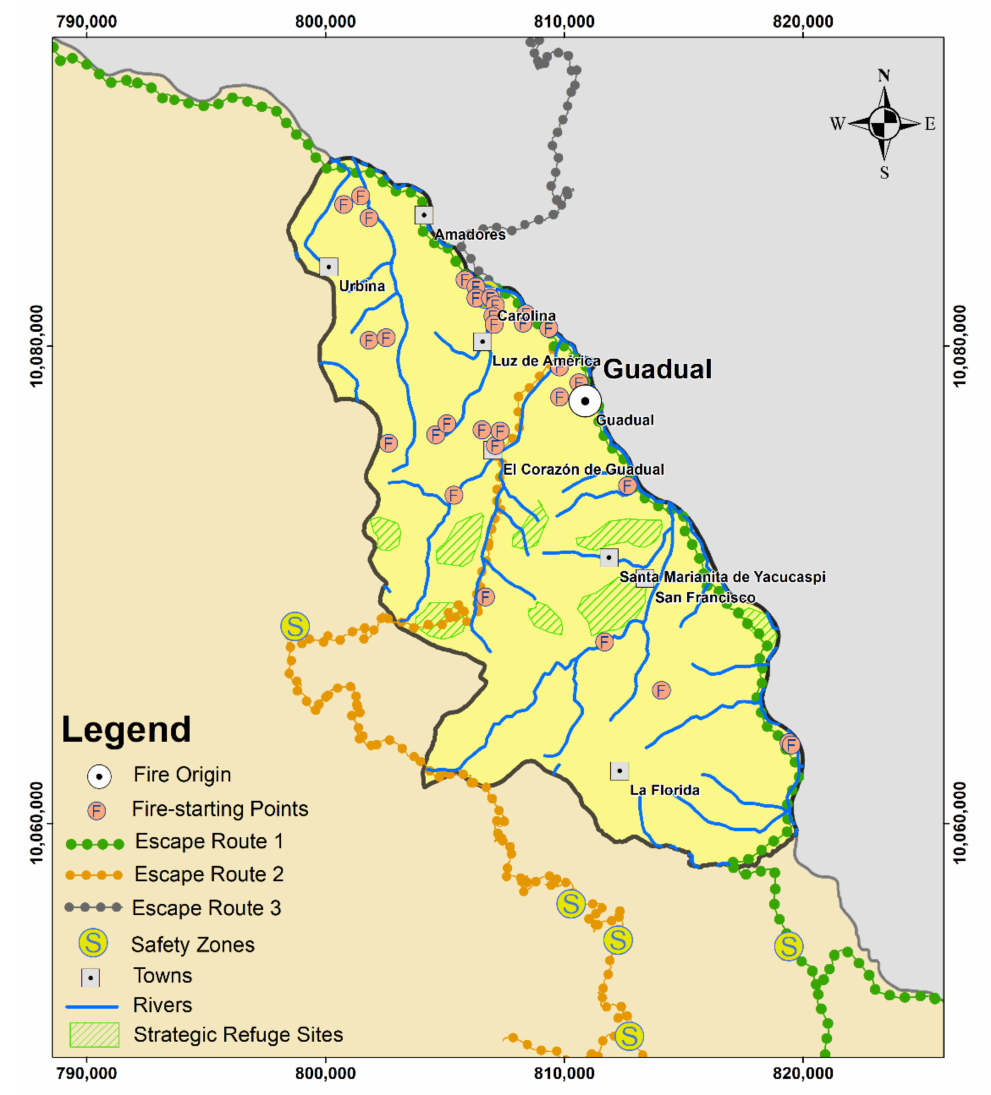
Figure 15. Evacuation route map in response to fires in La Carolina